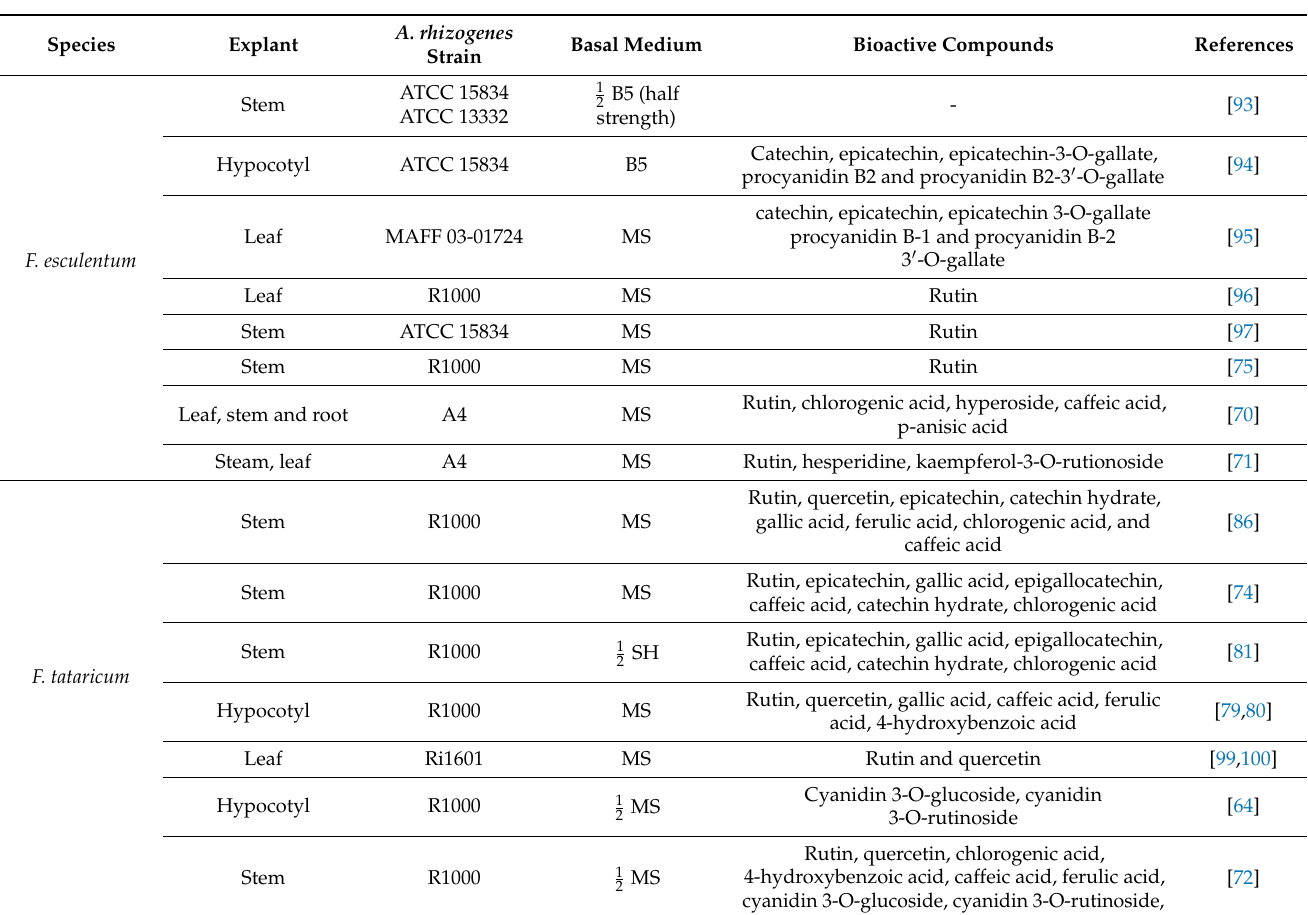
Table 3. Optimal conditions for the production of bioactive compounds with A. rhizogenes from different explants F. esculentum , F. tataricum